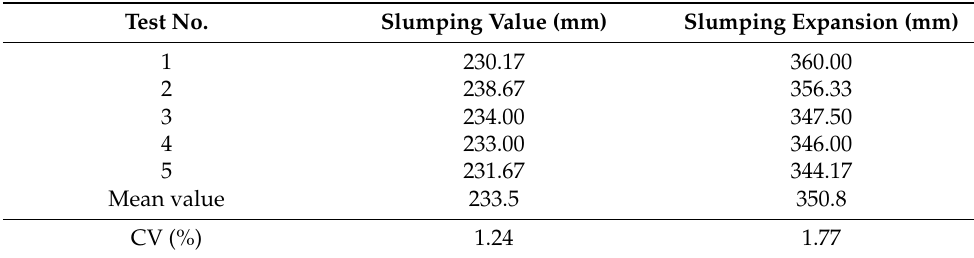
Table 2. Results of the slumping test in the laboratory.